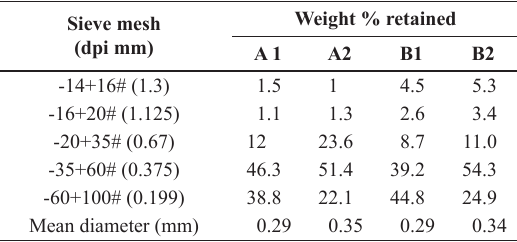
Table II. Particle size analysis of the filler sand (A1, A2, B1 and B2).